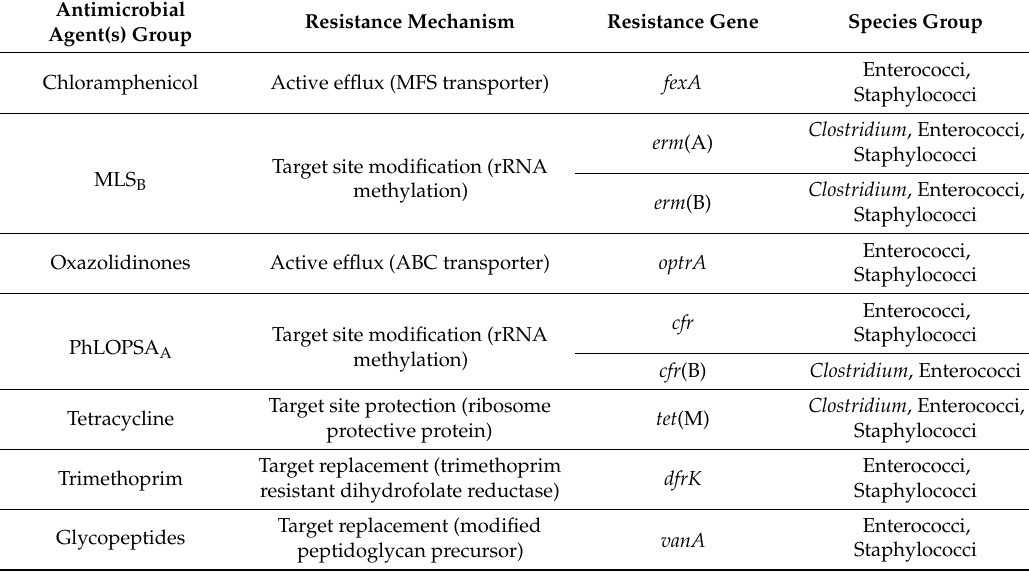
Table 2. Examples of common AMR-genes found in Clostridium , Enterococci and